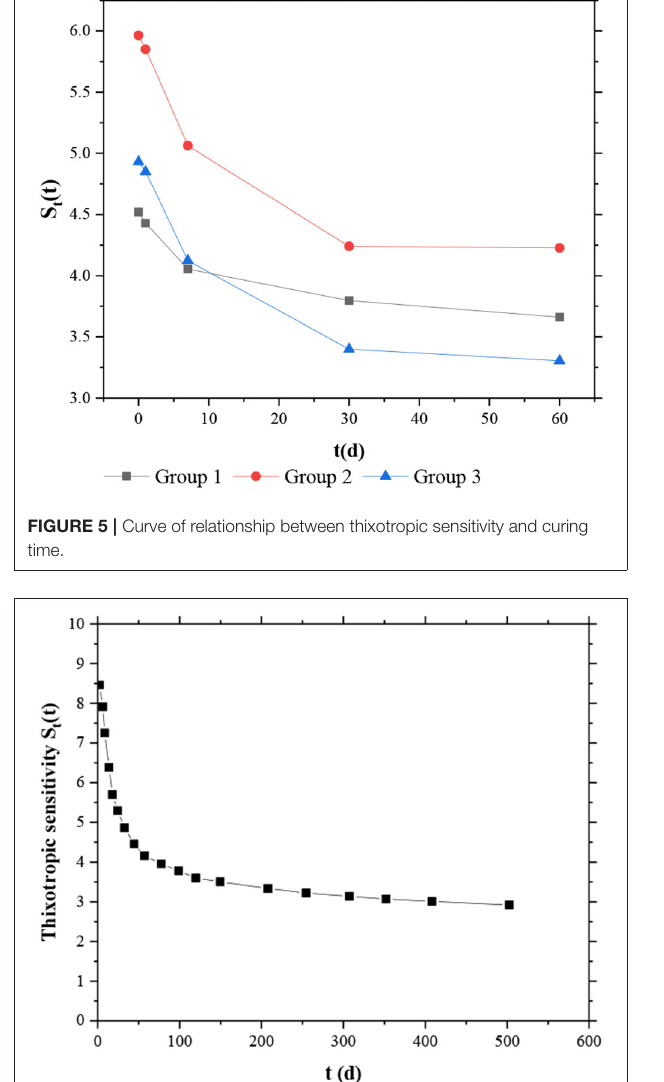
FIGURE 6 | Curve of relationship between thixotropic sensitivity and curing time [modified from Zhang et al. (2014b)].